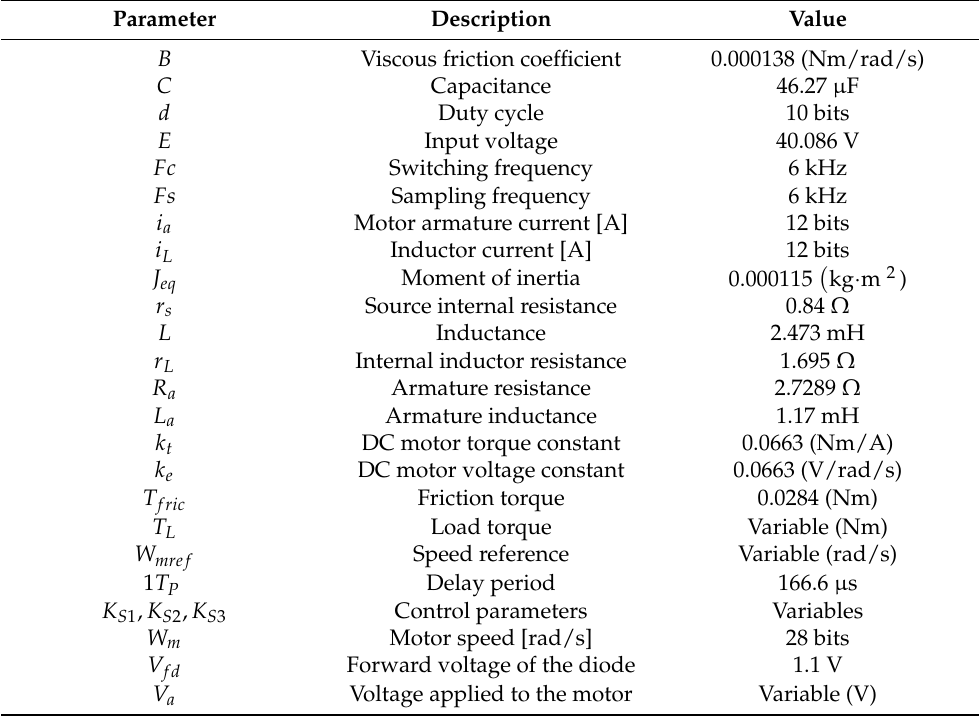
Table 1. Parameters of the buck-motor system and the